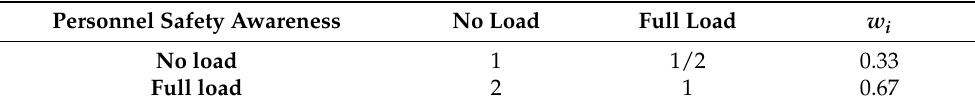
Table 19. Important judgment matrix of personnel safety awareness under different operating conditions.